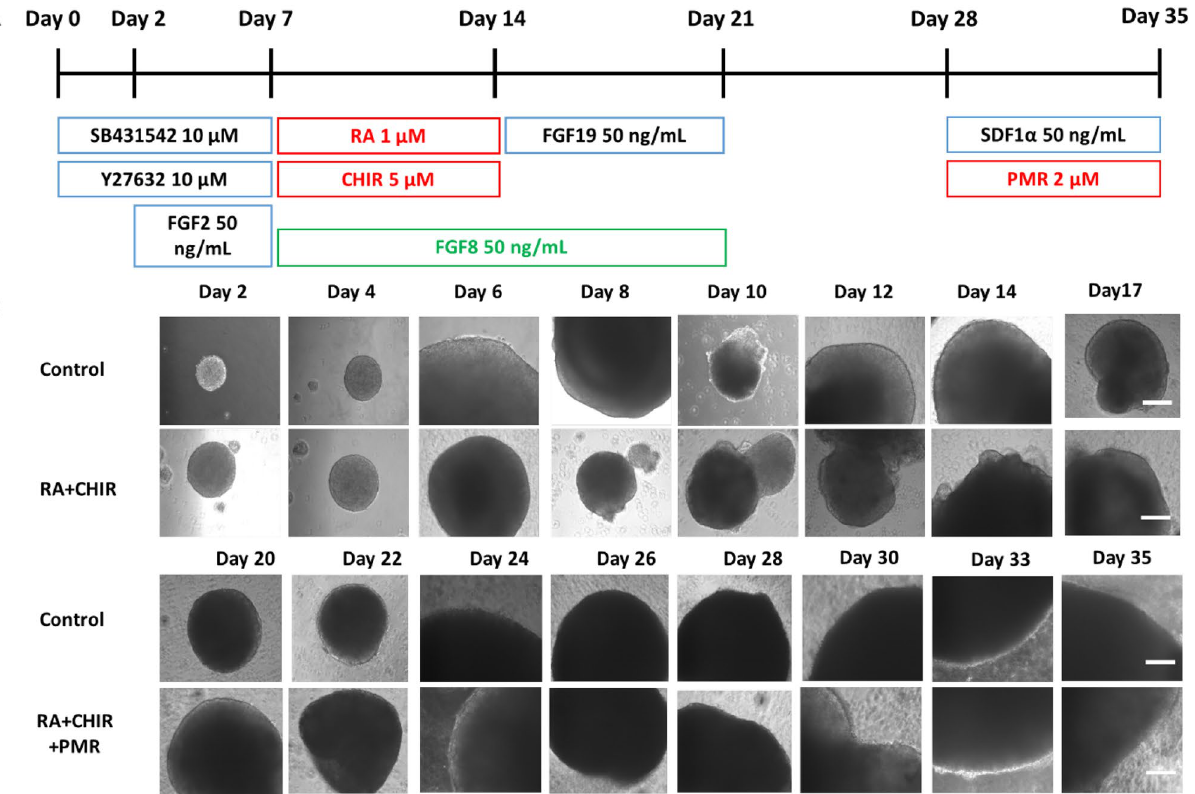
Figure 1. Protocols and morphology of cerebellar differentiation from hiPSCs. ( A ) Schematic illustration of the cerebellar differentiation from hiPSCs under different conditions. The control condition uses the factors written in the black font. The tested conditions are the combination of RA/CHIR/PMR (RCP) and FGF8 only. ( B ) Morphology of cerebellar spheroids during differentiation for 35 days. Scale bar: 200